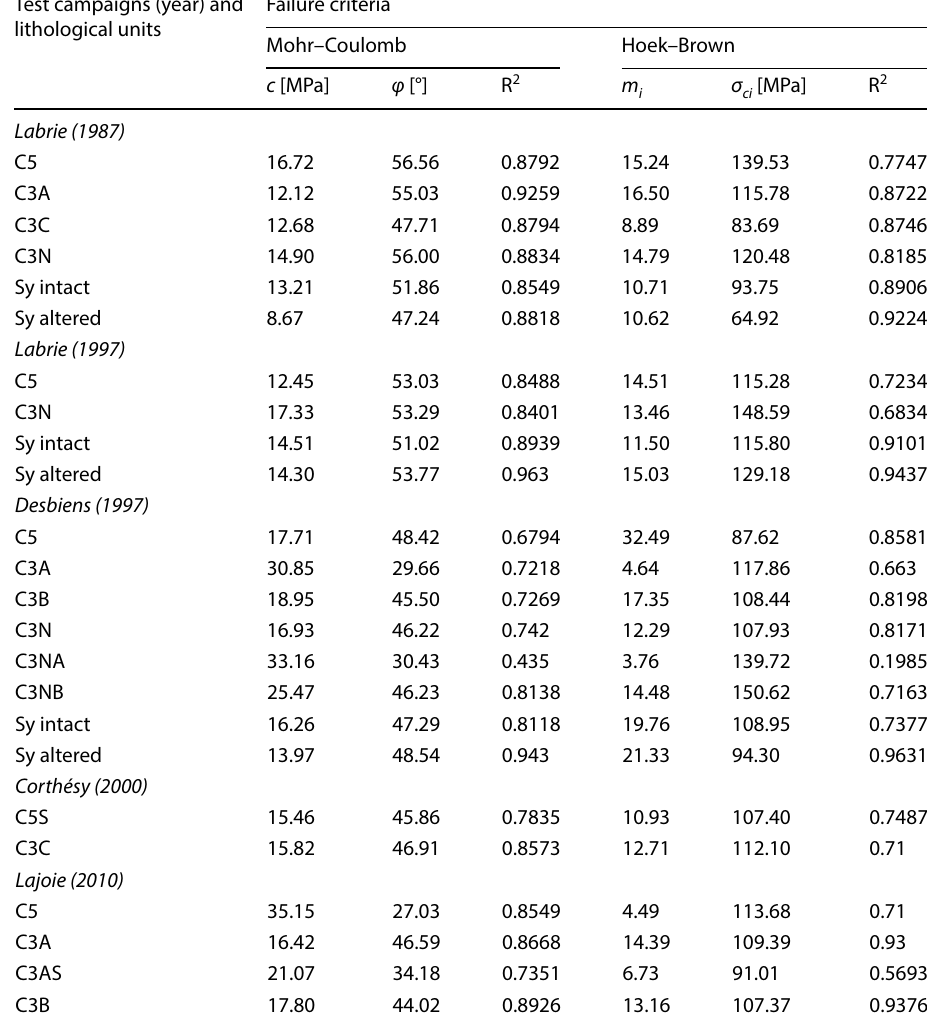
Table 7 The parameters of Hoek–Brown and Mohr– Coulomb failure criteria for each lithological unit